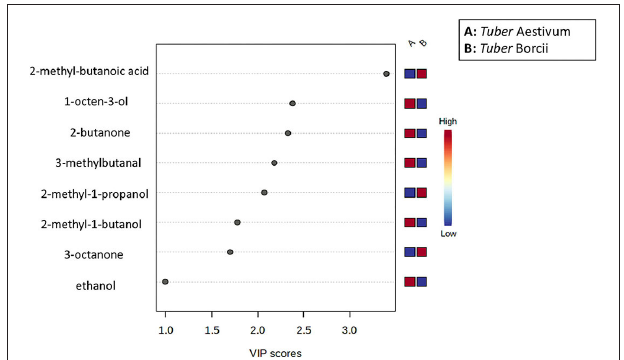
FIGURE 6 | VIP score showing the most important features causing greater variation in the PLS-DA model; The features causing higher variation are shown in red color, and those showing the lowest variation are shown in blue for each group (A: Tuber Aestivun, B: Tuber Borchii).